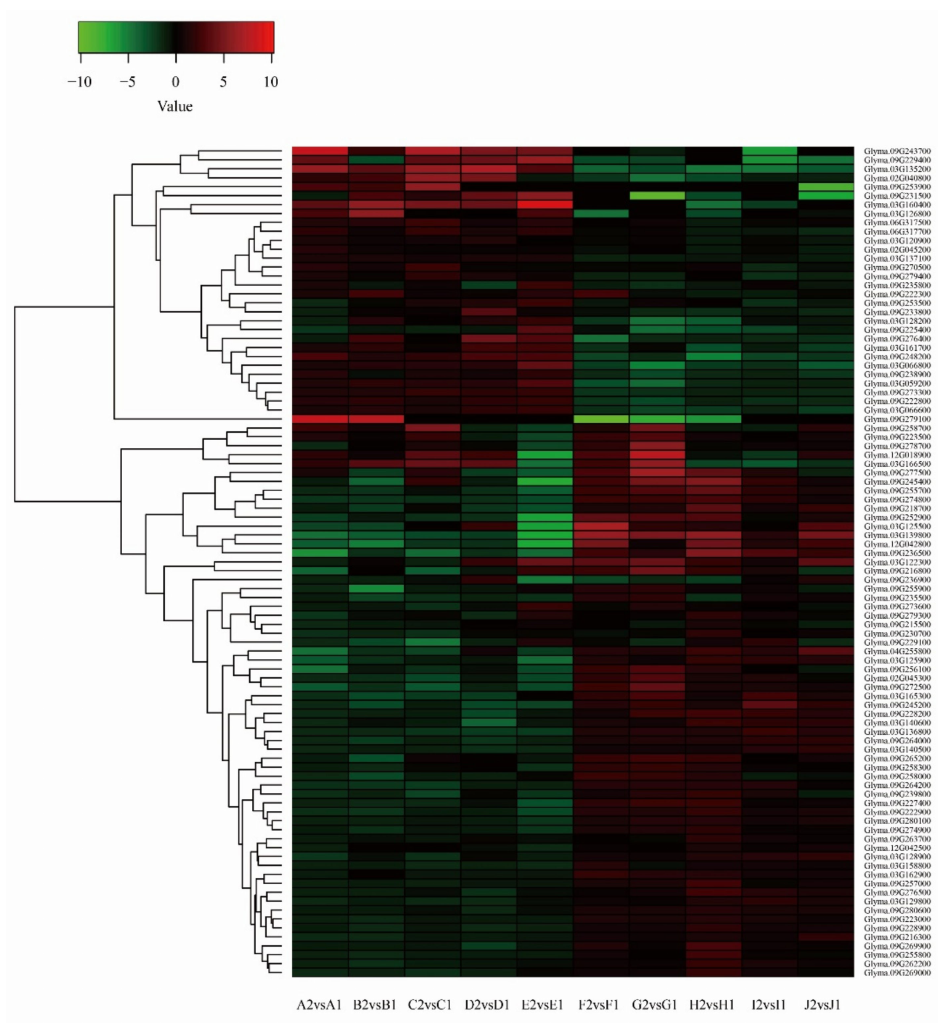
Figure 5. Cluster analysis of di ff erentially expressed genes (DEGs) after combining transcriptome sequencing and import